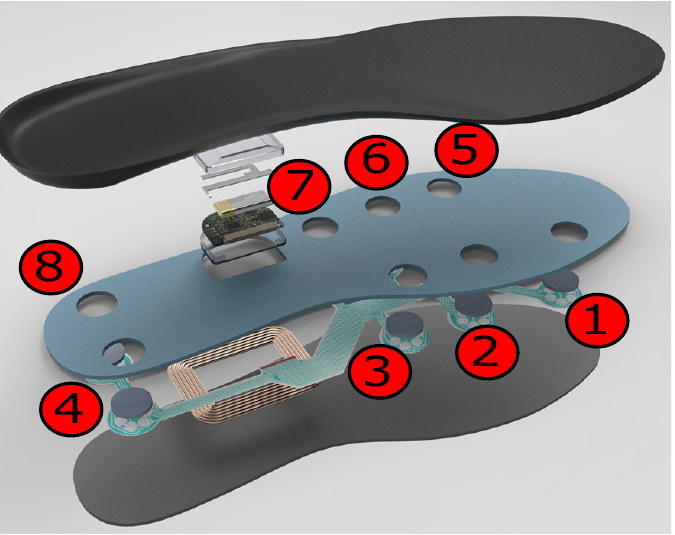
Figure 1. Smart insole to acquire plantar pressure data. Numbers 1–8 represent the positions of eight sensor nodes which measure the force exerted on the